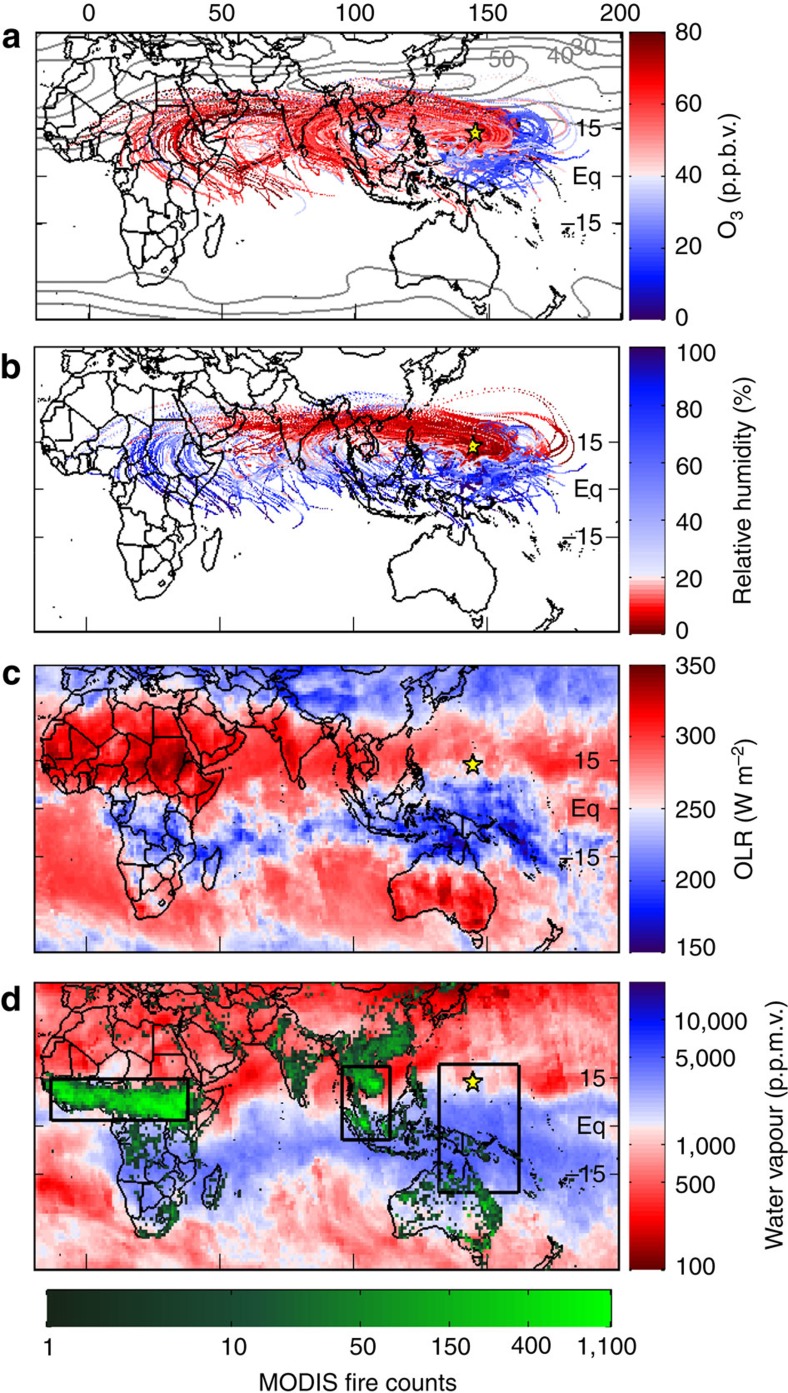
Origins of air in the TWP.(a) 10-day, HYSPLIT back trajectories for all CAST flights analysed here and CONTRAST RF03–05 and RF07–14 for observed pressures between 300 and 700 hPa. Trajectories are stopped when encountering convective precipitation and coloured by observed O3. For clarity, only every third is shown. Contours are zonal winds at 200 hPa averaged over January and February 2014 in 10 m s−1 intervals. The yellow star shows Guam. b Same as a but coloured by HYSPLIT RH along the trajectory (see methods). (c) AIRS daytime OLR averaged over CAST and CONTRAST flight days. d Same as c but for AIRS H2O at 500 hPa. MODIS fire counts are the total for January and February 2014. Black rectangles represent the African and Southeast Asian tropical biomass burning regions (determined subjectively by the high fire counts) and the CAST/CONTRAST study region.